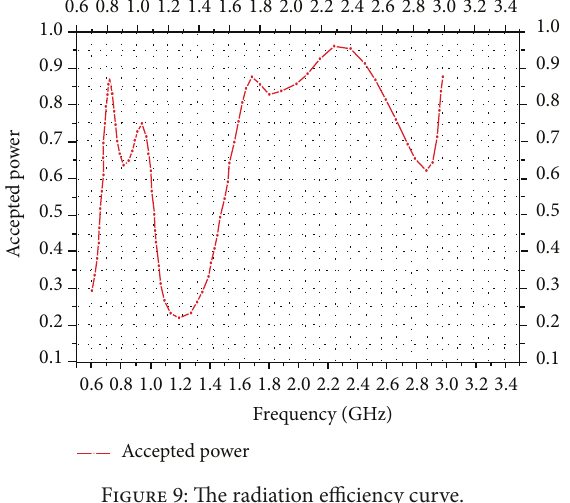
Figure 9: The radiation efficiency curve.